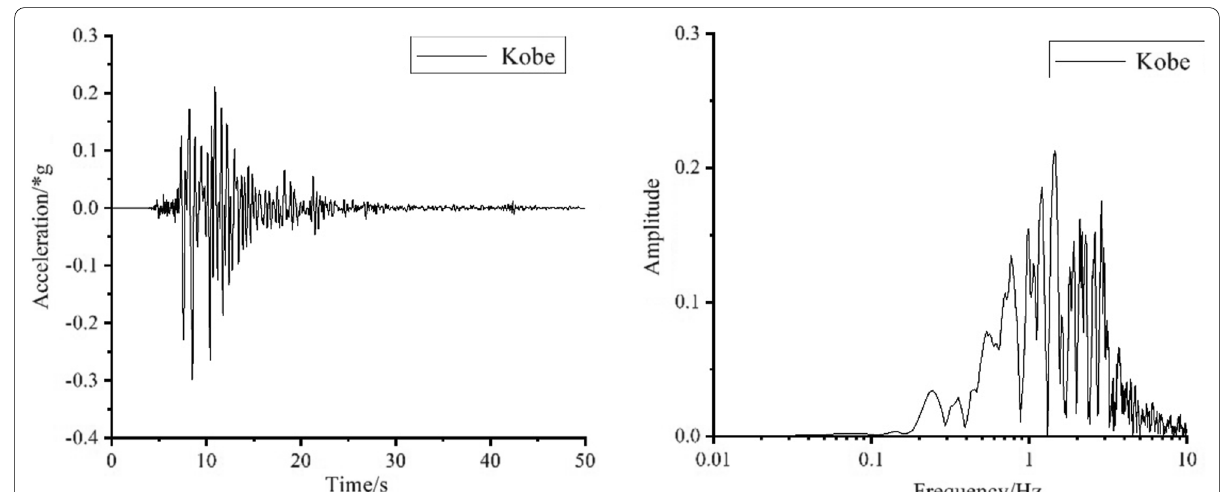
Fig. 3 Time history curve and Fourier spectrum of Kobe ground